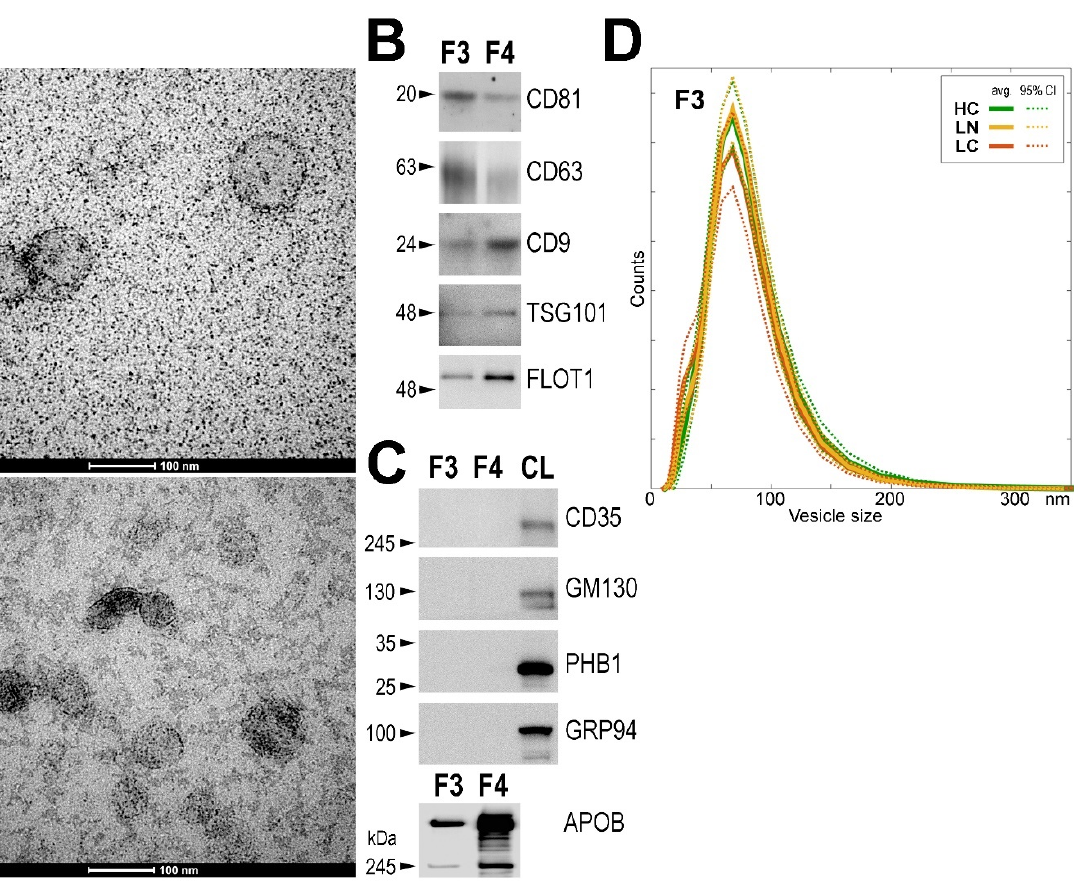
Figure 1. Characteristics of serum-derived sEV. ( A ) TEM imaging of vesicles present in fractions F3 and F4 (scale bars represent 100 nm); ( B ) presence of exosome markers and ( C ) markers of other cellular components detected by Western blot in sEV fractions F3 and F4; CL—positive control corresponding to whole cell lysates of human HCT116 cell. ( D ) Distribution of sizes of vesicles in sEV fraction F3 assessed by DLS measurement; average values (with 95% CI) in three groups of donors (healthy controls, HC; donors with benign lung nodules, LN; lung cancer patients, LC) are presented. Raw Western blot images are available in Figure S1.